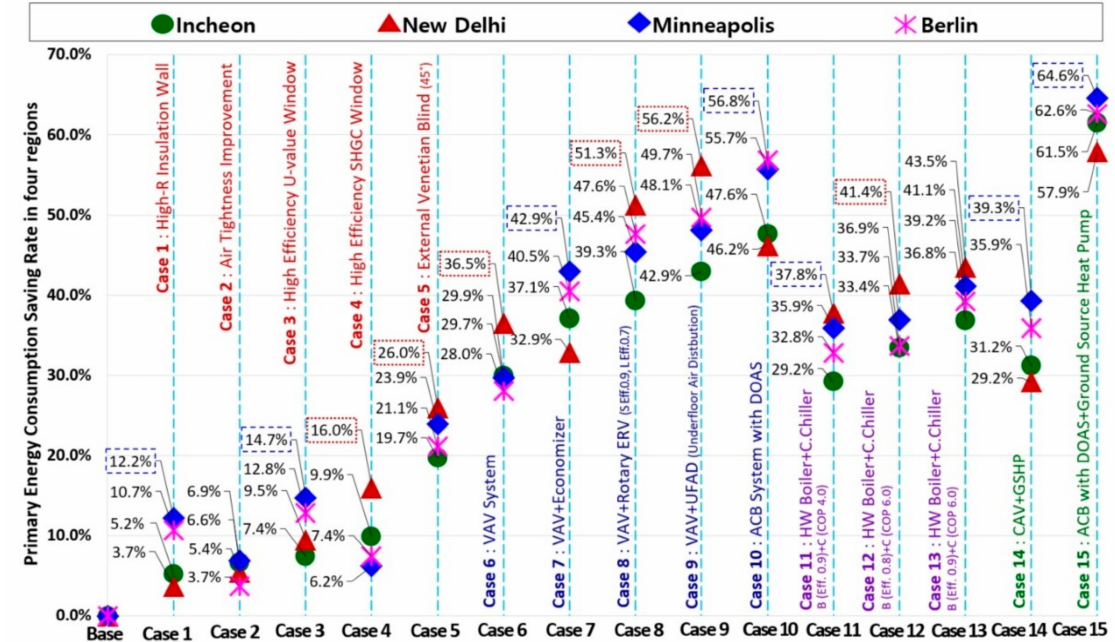
Figure 11. Comparative results of the energy saving rates in the four regions when using high-performance